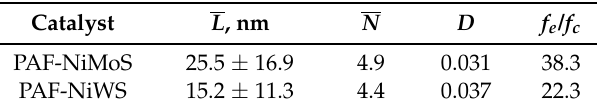
Table 1. Textural characteristics of the metal sulfides.